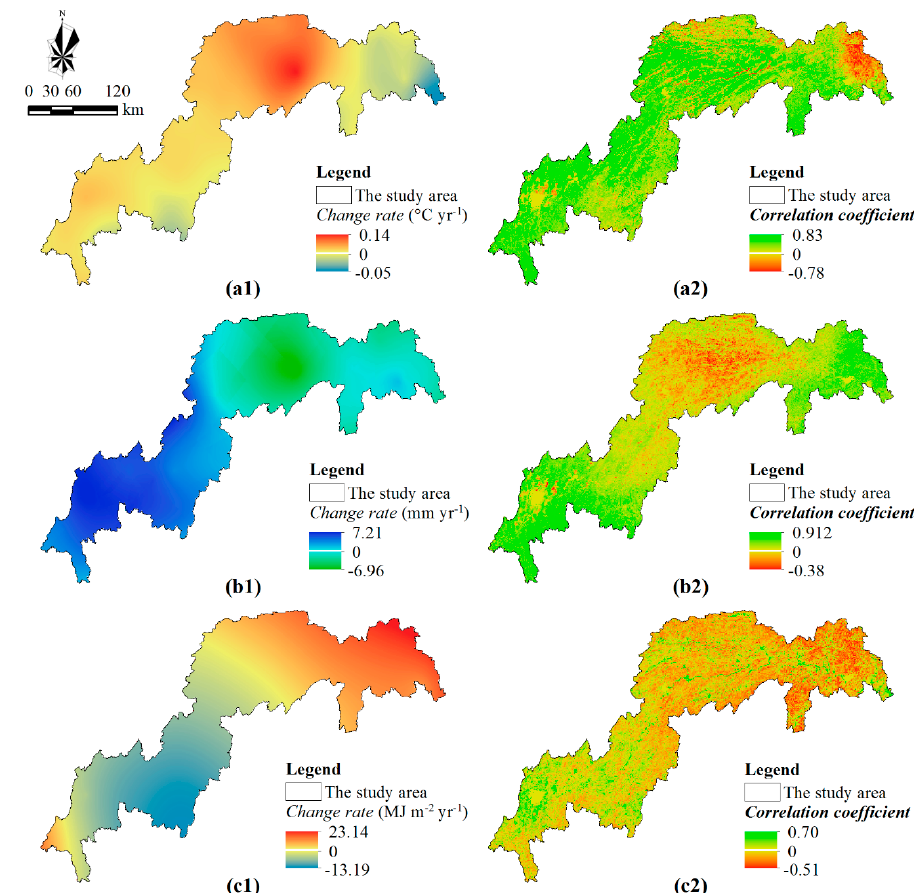
Figure 6. Spatial variation of climate variables and Spearman’s rank correlations between the annual NPP and these variables for the period 2000–2015. Note: The least-square linear regression model was applied to analyze the temporal variations of these climate variables for each pixel, and the change trend is described by the modeled slope in the figures of ( a1 , b1 , c1 ). The Spearman’s rank correlation coe ffi cient was applied to analyze the relationship between NPP and climate variable in the figures ( a2 , b2 , c2